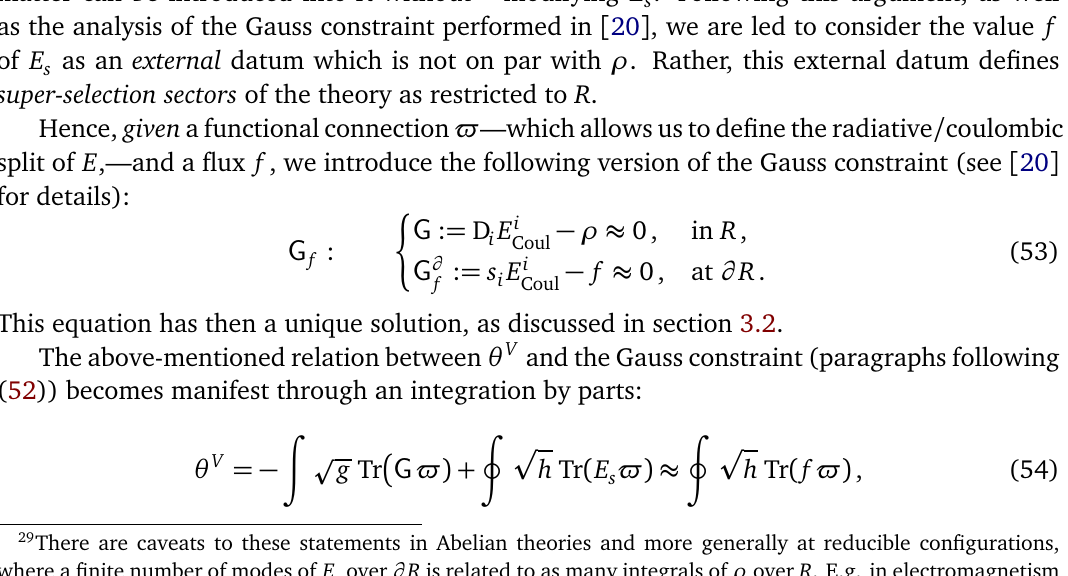
Figure 4: A graphical representation in T A of E orthogonal complements of V choice (cid:36) = (cid:36) is, only with this choice do the pictures on the right and left align—see section